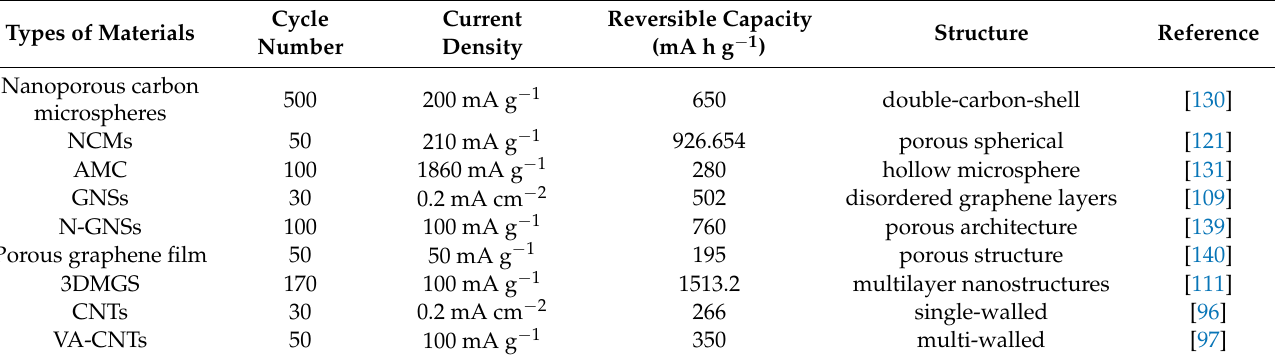
Table 1. Comparison of electrochemical properties of carbon microspheres, graphene and carbon nanotubes.